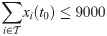
Initial tumor compositions for clinical feasible protocols.10, 000 randomly selected initial tumor compositions used to analyze the clinically feasible protocols. All total tumor volumes satisfy the patient viability constraint ∑i∈Txi(t0)≤9000.